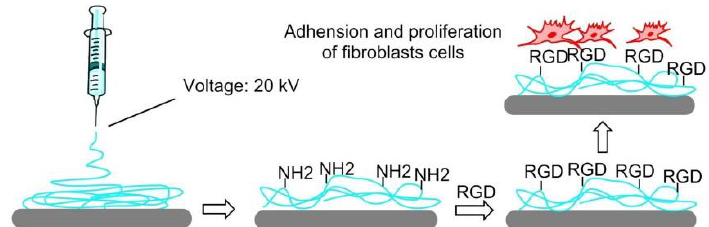
Figure 13. The electrospin strategy for surface functionalization. A mixture of PLGA (poly(lactic-co-glycolic acid)) and PLGA-b-PEI-NH 2 in DMF/THF was electrospun to produce nanofiber with free NH 2 -group, which can be used to conjugate RGD peptides. Fibroblasts were used to study cell adhesion, spreading, and proliferation.